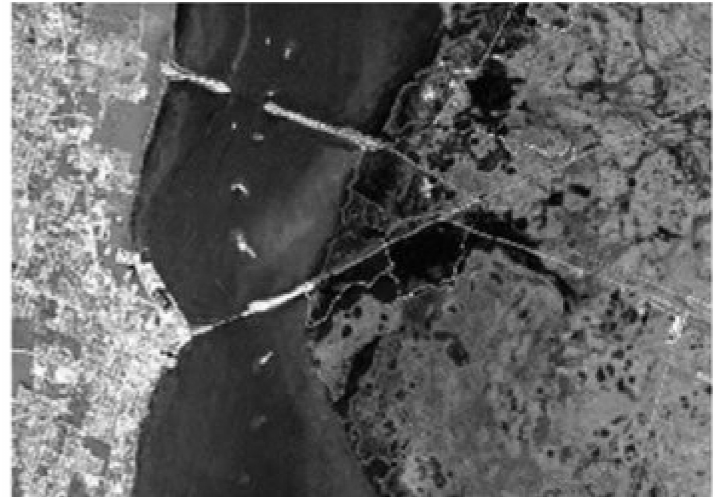
Figure 2. Sample band from the Kennedy Space Center